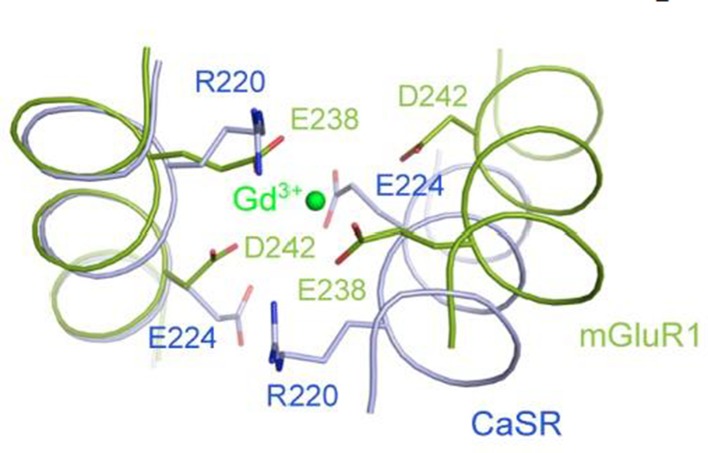
Superposition of the CaSR and mGluR1 structures in the region of the Gd3+-binding site in mGluR1 structure.